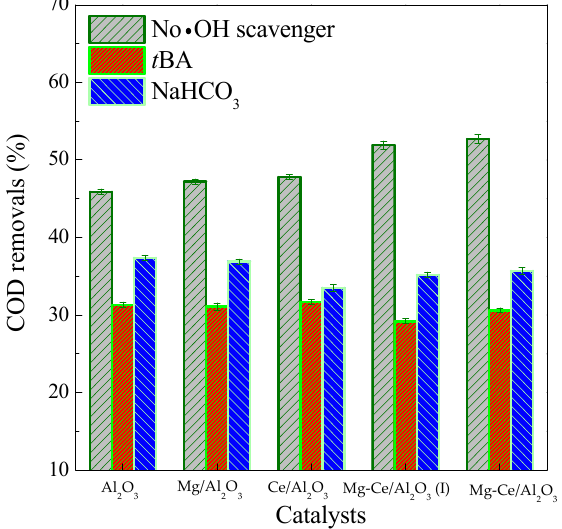
Figure 8. Influence of • OH scavengers (1 g/L) on COD removals of RPRW over COPs (note: 0.5 g